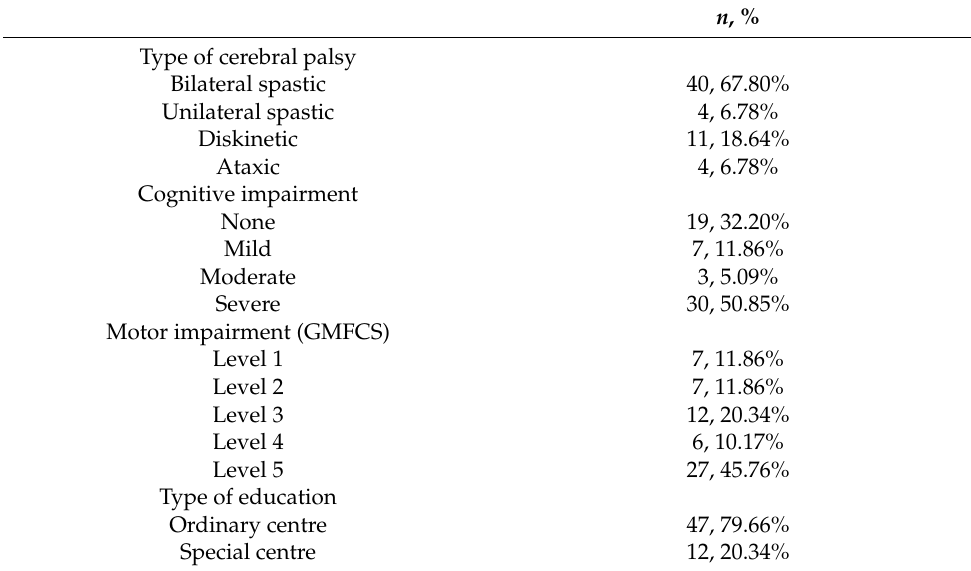
Table 2. Clinical characteristics of children with cerebral palsy. GMFCS = Gross motor function classification system (1 = walks without limitations, 5 = transported in a manual wheelchair)